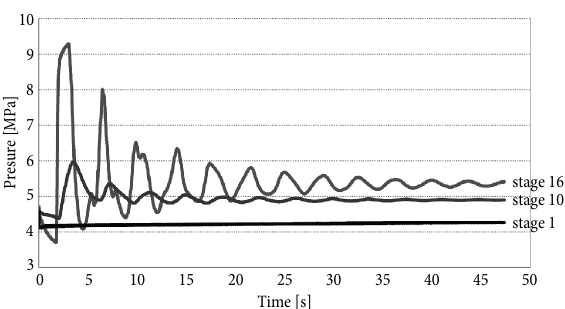
Fig. 5. Dependencies of pressure in the 1st, 10th and 16th stages of centrifugal pump over time